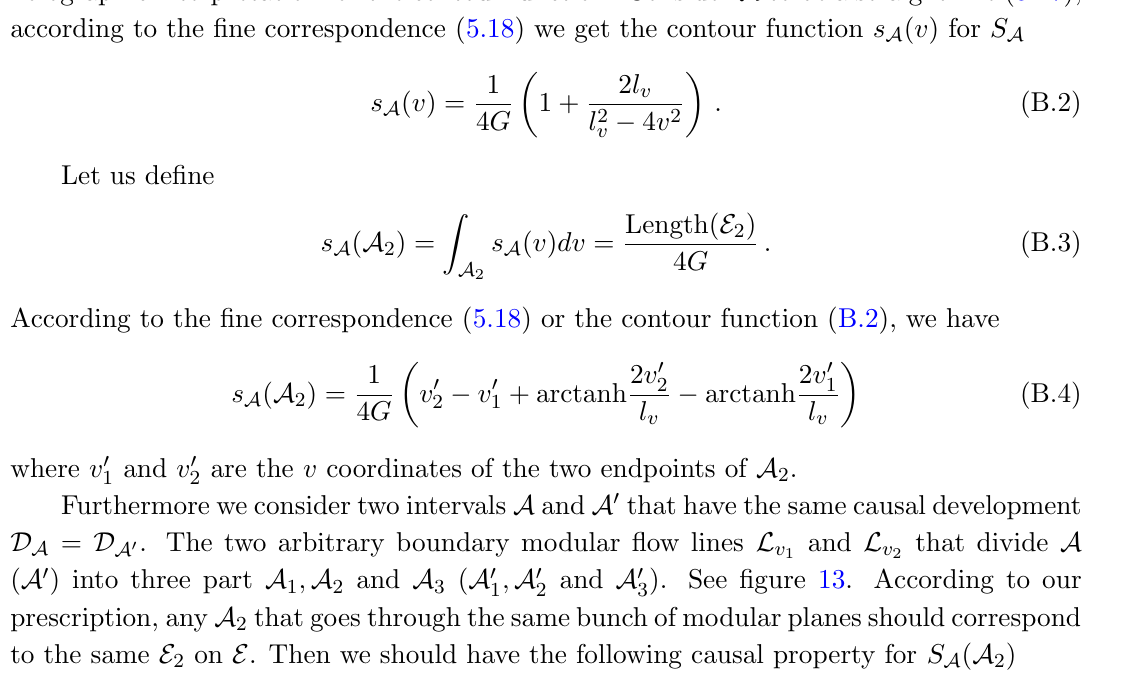
Figure 13 . The two blue lines are two modular (cid:13)ow lines L v and A 0 intersect with the same bunch of modular planes between P ( v 1 ) and P ( v 2 ). 2 holographic interpretation for the contour function. Consider A to be a straight line